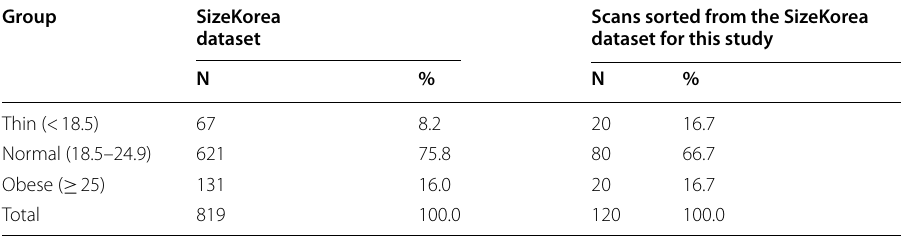
Table 3 BMI (Body Mass Index) Groups